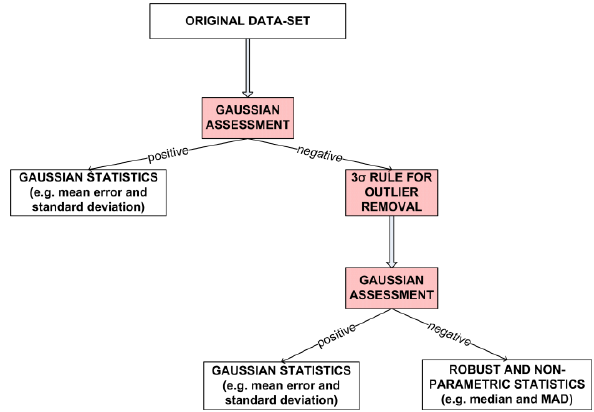
Figure 6. Statistical